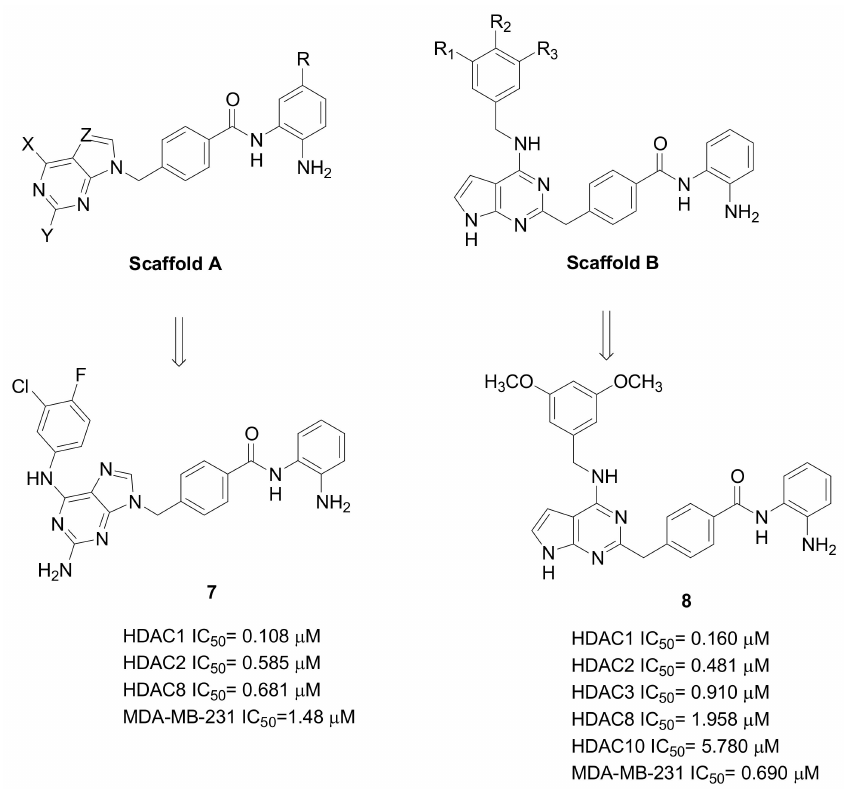
Figure 8. Chemical structures of purine and pyrimidine-based benzamides as Class-I HDACIs with promising activity against TNBC.